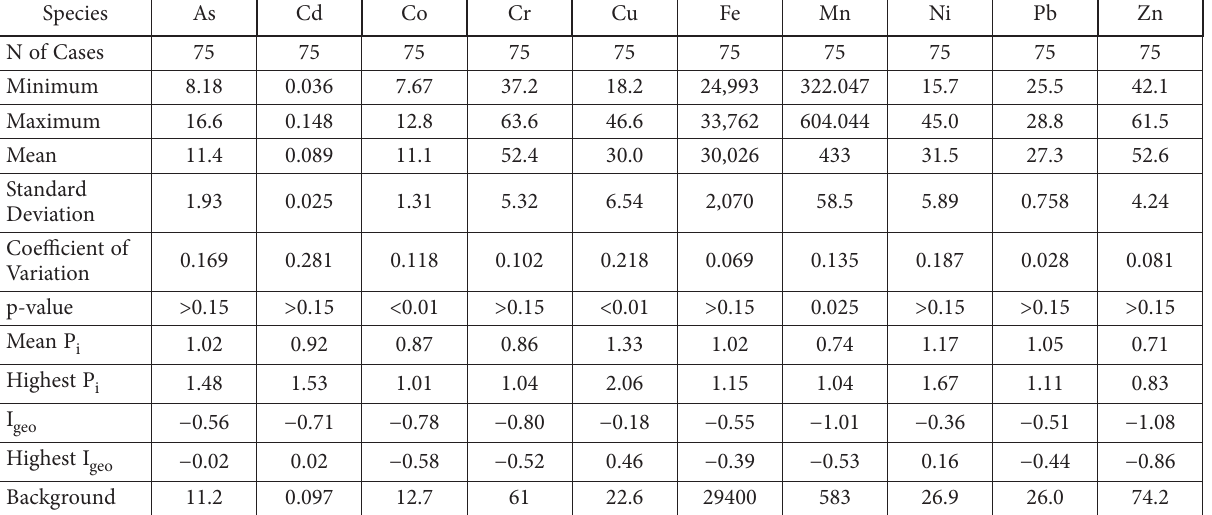
Table 1. Descriptive statistics of heavy metal concentrations (mg/kg) in the soil samples